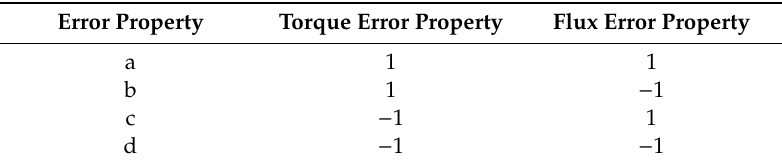
Table 2. Error property compound modes.